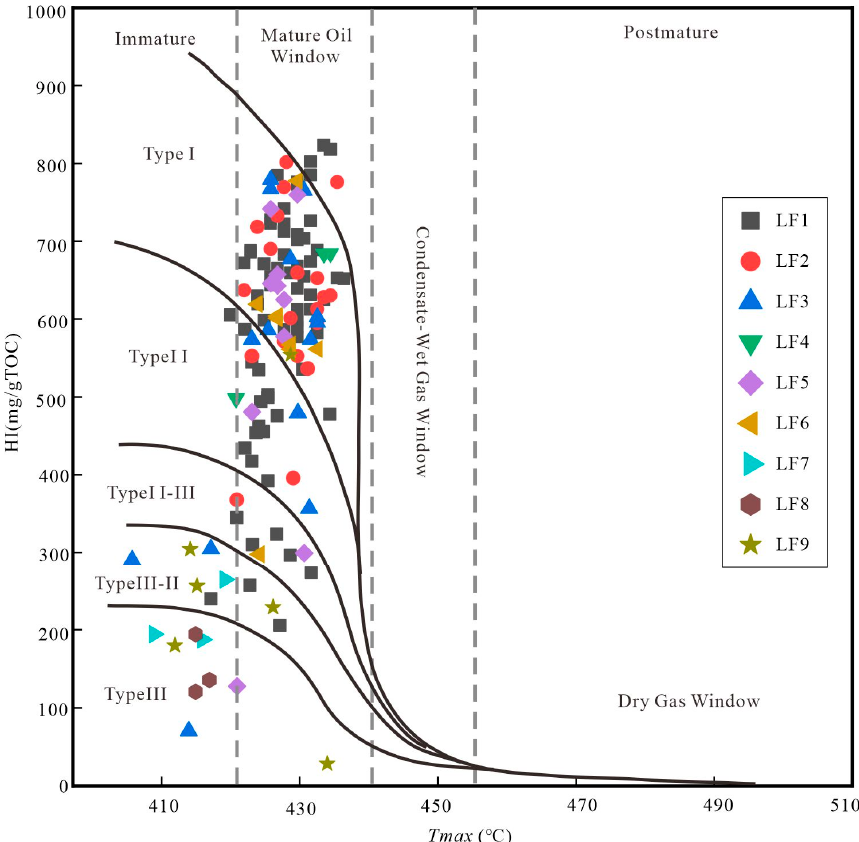
Figure 6. The plot of the hydrogen index (HI) versus the pyrolysis temperature of maximum yield of pyrolysate ( T max ) for different lithofacies in Es4s in Dongying Depression that displays the kerogen types and the thermal maturity stages (modified from [50]).